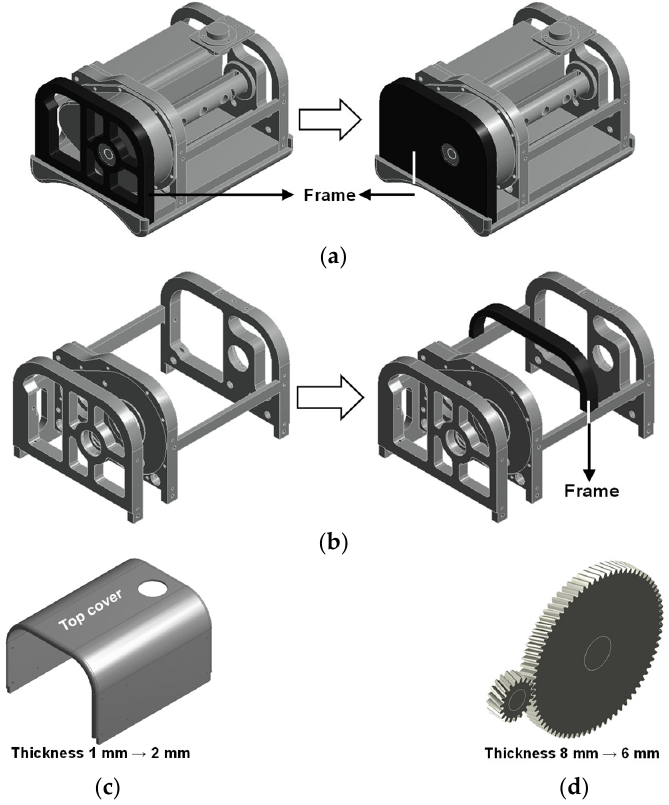
Figure 9. Design variable–Structure: ( a ) Case 5: Change frame to solid type; ( b ) Case 6: Add arched frame; ( c ) Case 7: Increase the thickness of the top cover; ( d ) Case 8: Reduced gear thickness.